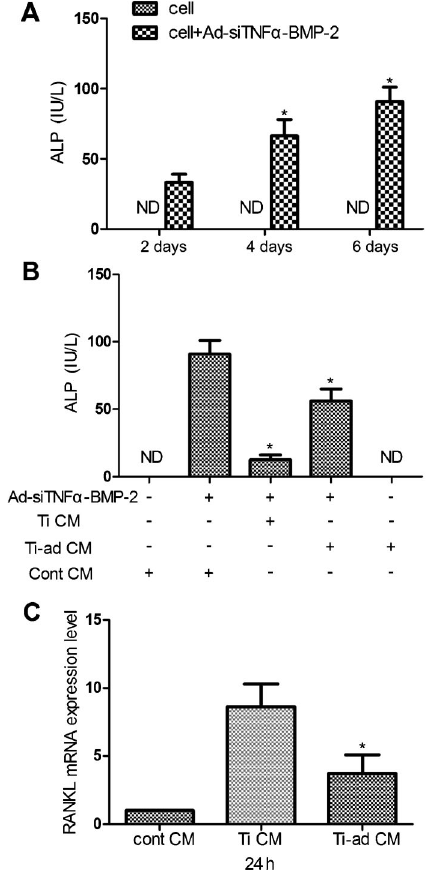
Figure 4. Induction of osteoblast differentiation evaluated by a combination of treatment with conditioned medium (CM; Ti CM and Ti-ad CM) and Ad-siTNF a -BMP-2. Inhibition of RANKL mRNA expression in MC3T3-E1 cells was evaluated by a combination of treatment with CM (Ti CM and Ti-ad CM). Data are reported as means±SD. Similar results were obtained in three independent experiments. A , MC3T3-E1 cells were plated on 24-well cluster plates at a density of 1 6 10 5 cells/well. After 24 h, MC3T3-E1 cells were treated with Ad-siTNF a -BMP-2 (50 MOI), ALP activity levels were assessed for 2-6 days. *P , 0.05, compared to the treatment with Ad-siTNF a -BMP-2 (50 MOI) at 2 days. B , ALP activity was assessed in MC3T3-E1 cells treated with Ad-siTNF a -BMP-2 (50 MOI) and CM [cont (control) CM, Ti CM and Ti-ad CM] at 6 days. *P , 0.05, compared to the treatment with a combination cont CM and Ad-siTNF a -BMP-2. C , MC3T3-E1 cells were treated with CM (cont CM, Ti CM and Ti-ad CM) for 24 h. RANKL mRNA expression was assessed by real-time RT-PCR. MOI: multiplicity of infection, ND: not detected. *P , 0.05,compared to the treatment with Ti CM (one-way